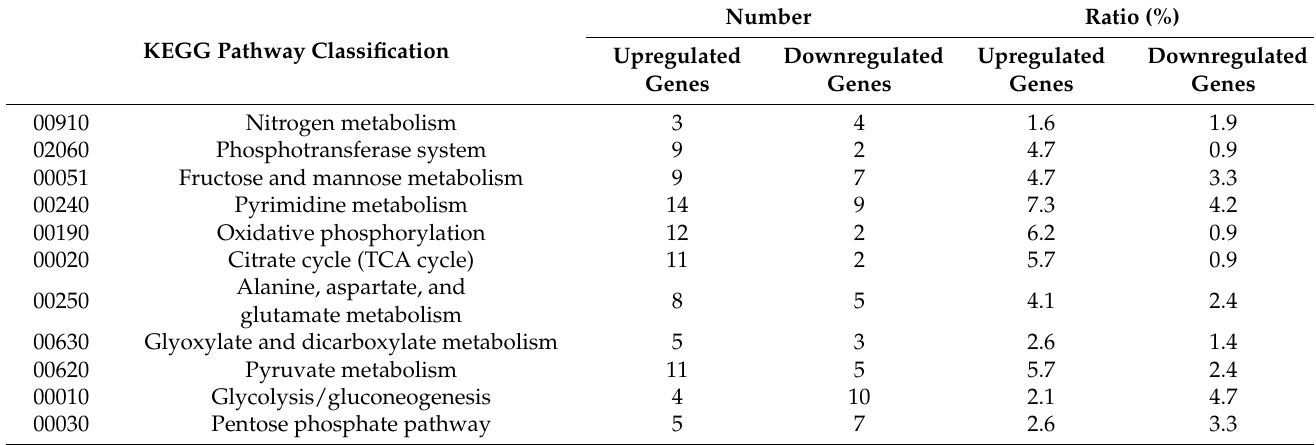
Table 2. KEGG pathway functional annotation of differentially expressed